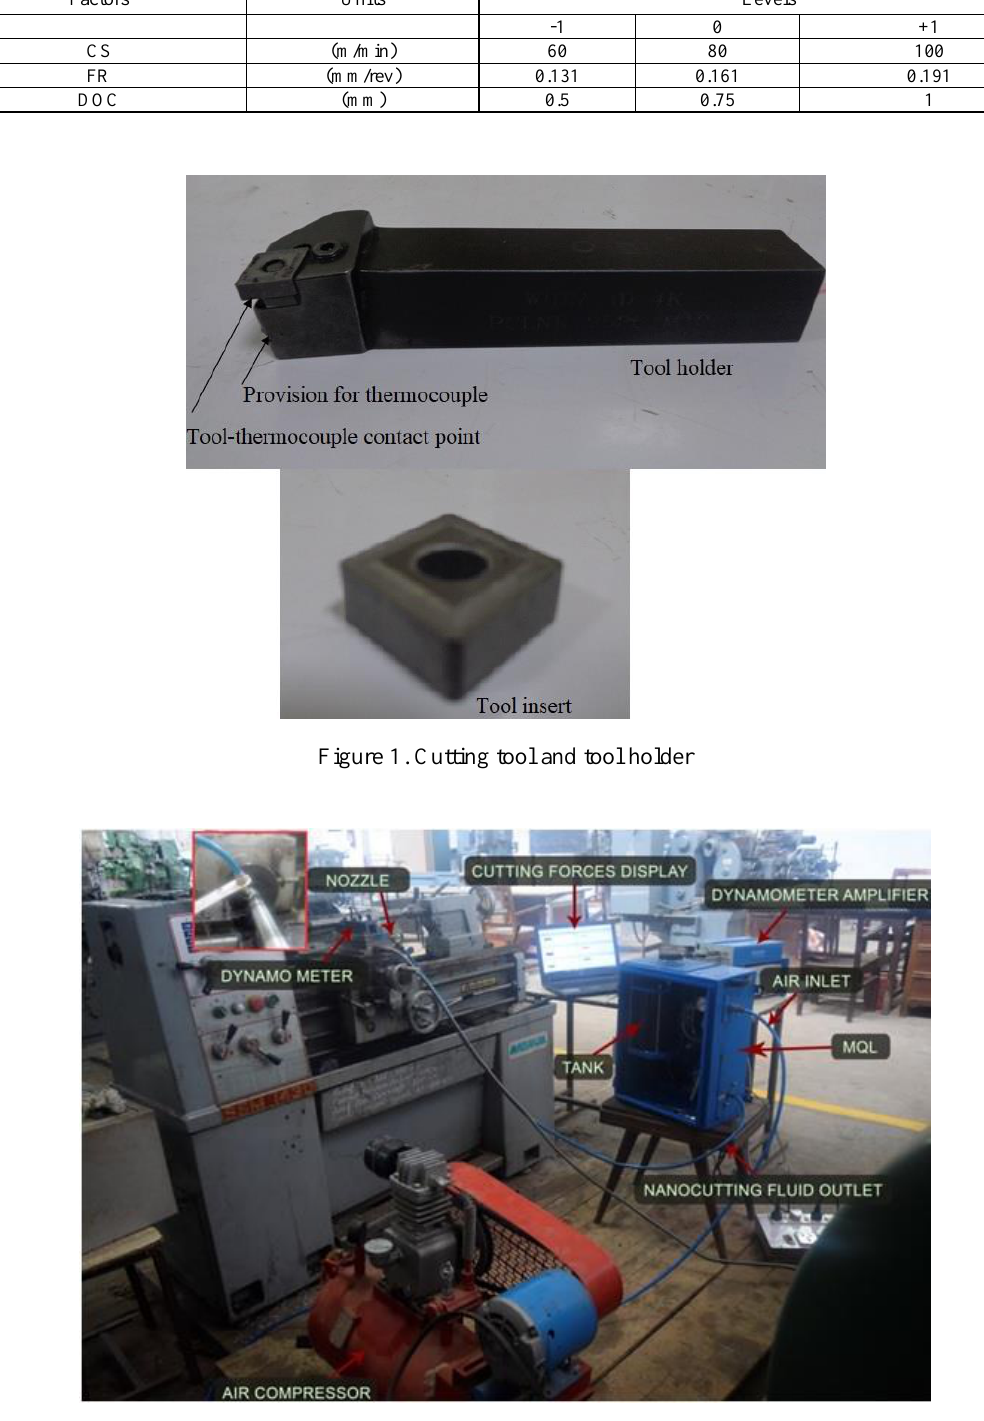
Figure 2. Machining experimental setup for turning under minimal quantity